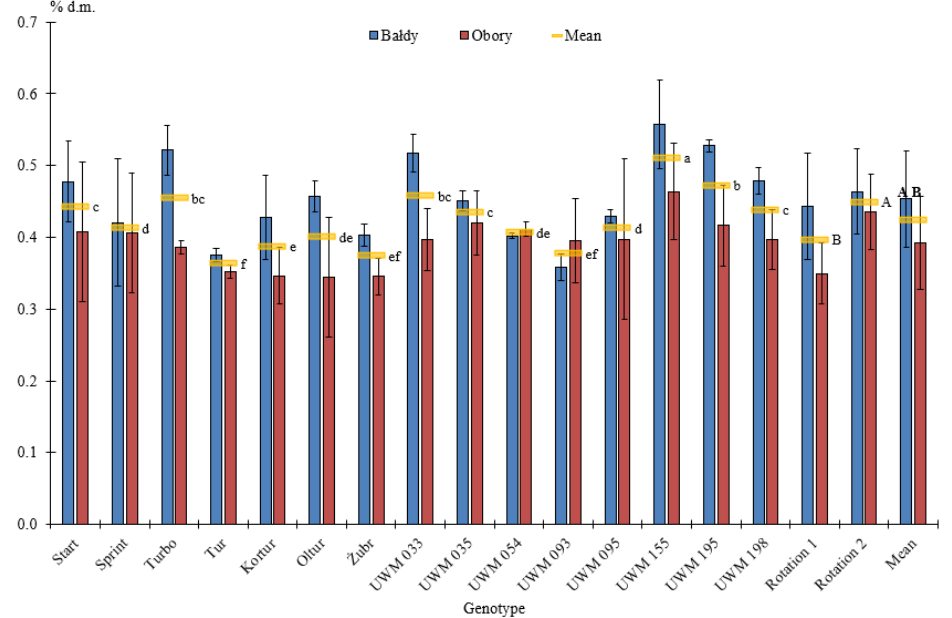
Figure 10. Nitrogen content in the biomass of 15 willow genotypes obtained at two locations in two consecutive three-year harvest rotations; (legend: see Figure 1).